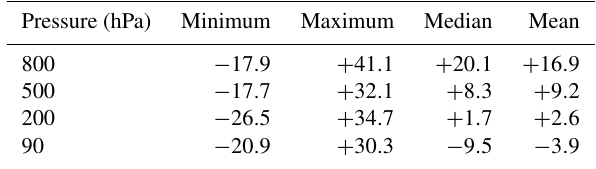
Table 4. NMB (%) of ozone mixing ratios for the E2005 simulation relative to the Tilmes et al. (2012) ozonesonde